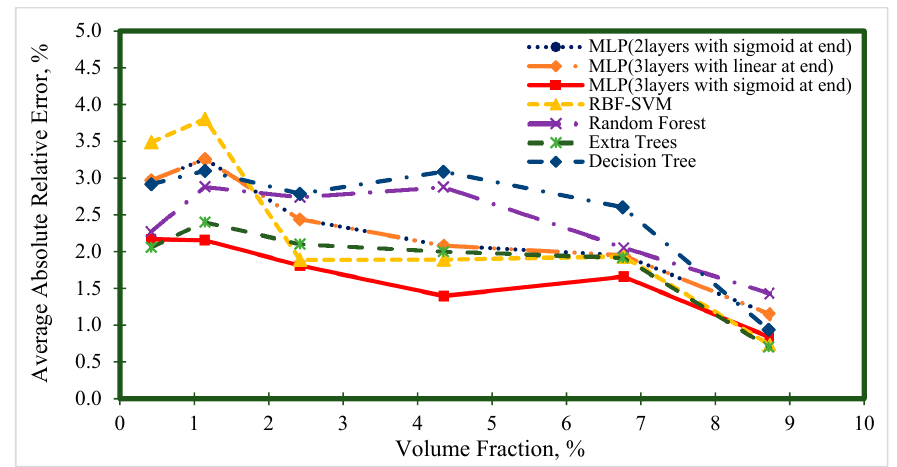
Figure 8. Average absolute relative error at different volume fraction ranges for prediction of the viscosity of nanofluids.